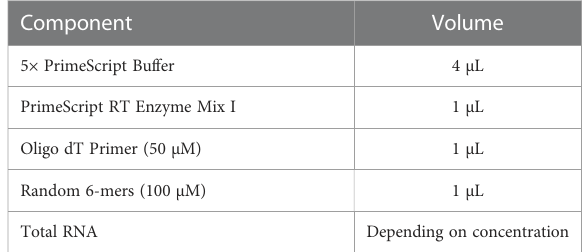
TABLE 1 Reverse transcription system (20 µL).